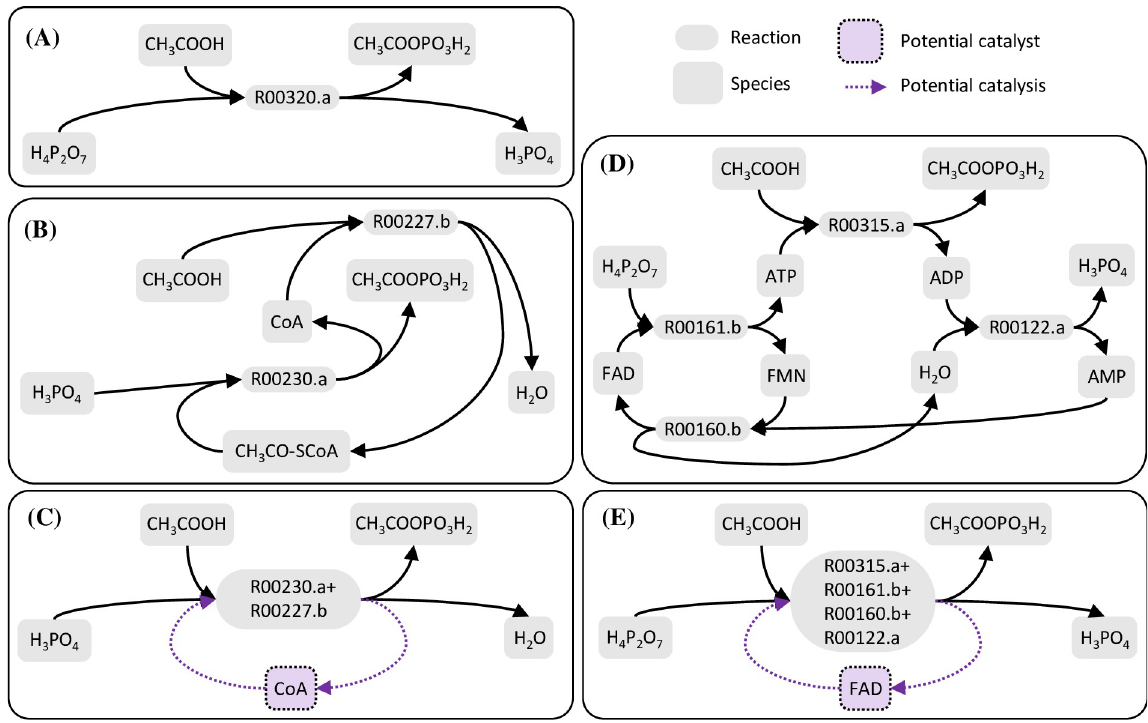
Fig 6. Adenine-based cofactors provide alternative paths for acetic acid phosphorylation. (A) Acetic acid can be directly phosphorylated by reacting with pyrophosphate. (B) With CoA present, an alternative path to phosphorylate acetic acid by consuming phosphate rather than pyrophosphate becomes possible. (C) We may say that CoA opens up and catalyzes a phosphate-dependent path of acetic acid phosphorylation. (D) With FAD present, an alternative path to phosphorylate acetic acid still by consuming pyrophosphate is possible. (E) If the composite reaction rate of the FAD-dependent path is faster than that of the direct phosphorylation, we may say that FAD can catalyze the pyrophosphate- dependent phosphorylation of acetic acid.